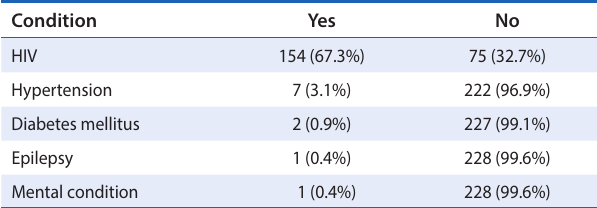
Table 2: Tuberculosis and concurrent medical conditions Condition